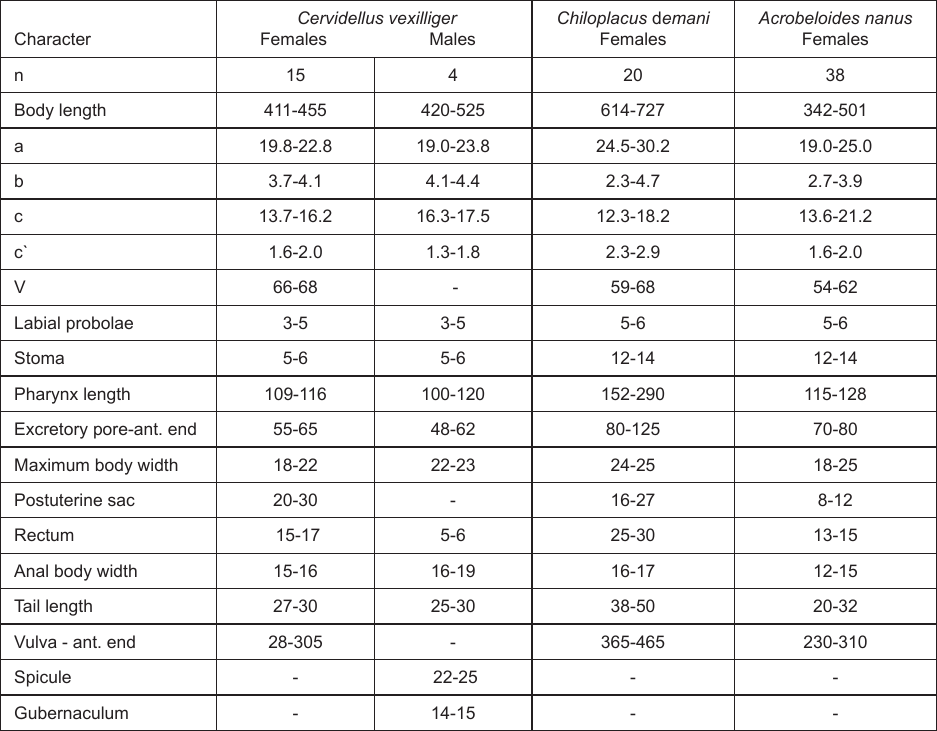
Description: Female: Body small. Straight to slightly curved upon fixation. Cuticle annulated. Lateral field marked by five incisures. Lip region slightly expanded, with three labial